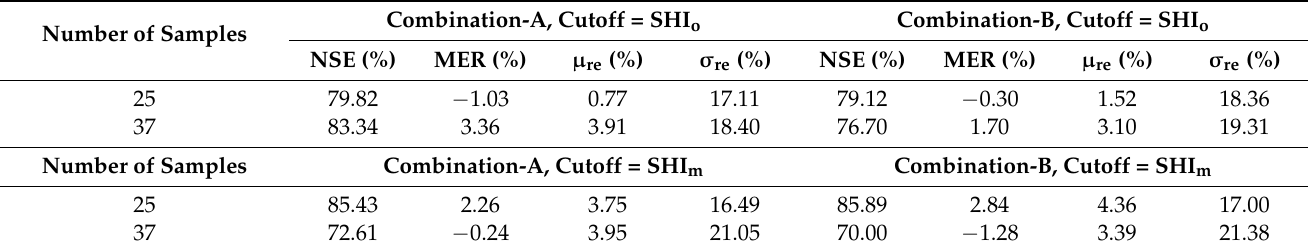
Table 5. Summary of performance statistics for the cutoff level at SHI o and SHI m with a varying sample size. Combination-A, Cutoff = SHI Number of Samples